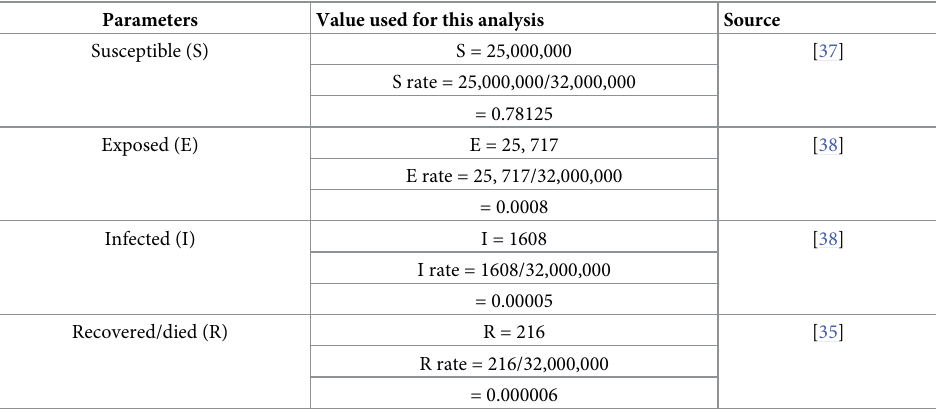
Table 1. SEIR Parameters